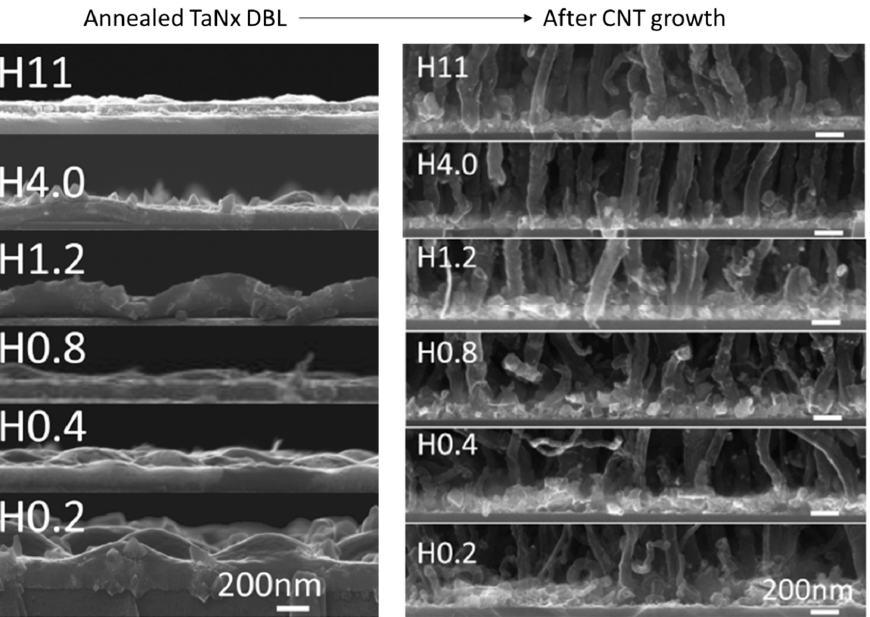
Figure 6. SEM micrographs ( left column) for the variation range of TaNx DBLs after annealing under Ar flow and ( right column) the same after successive growth of CNT with exposed DBL/CNT interface. Reproduced with permission from Bouchet-Fabre, Applied Surface Science; Ref. [78] copyright 2014, Elsevier.